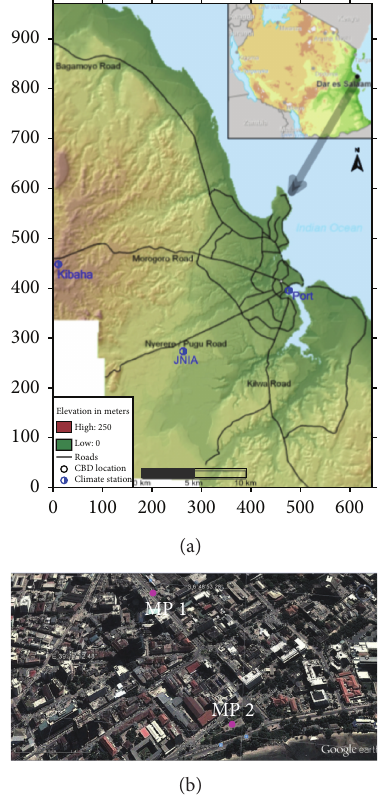
Figure 1: (a) Location of measurement stations and area of study. Source:modifiedfromHillandLindner(2010).(b)Asatellitepicture as obtained from Google Earth, locating the simulation points, MP1 (typical urban street) and MP2 (urban park), in a part of Dar es Salaam city,